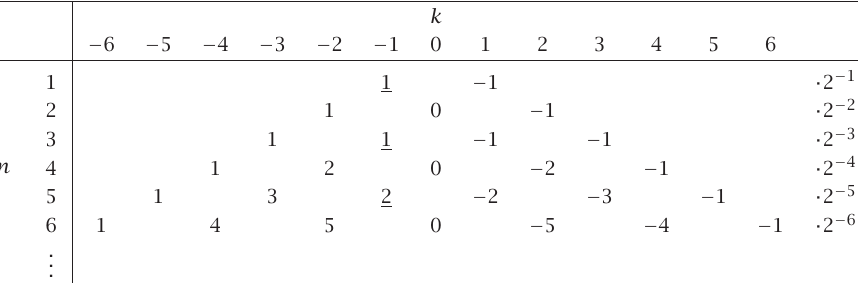
Table C.1 . The first values of Q 1 (n,k) = Q 1 (n,k, 1 / 2 ) . The absolute value of the number in row n and column k represents the number of ways which lead without absorption to point k after the n th steps. Multiplication of the number by the factor 2 − n yields Q 1 (n,k) . The last column contains these factors. Multiplication of the underlined number in row n by 2 − n yields Q 1 ( 2 n